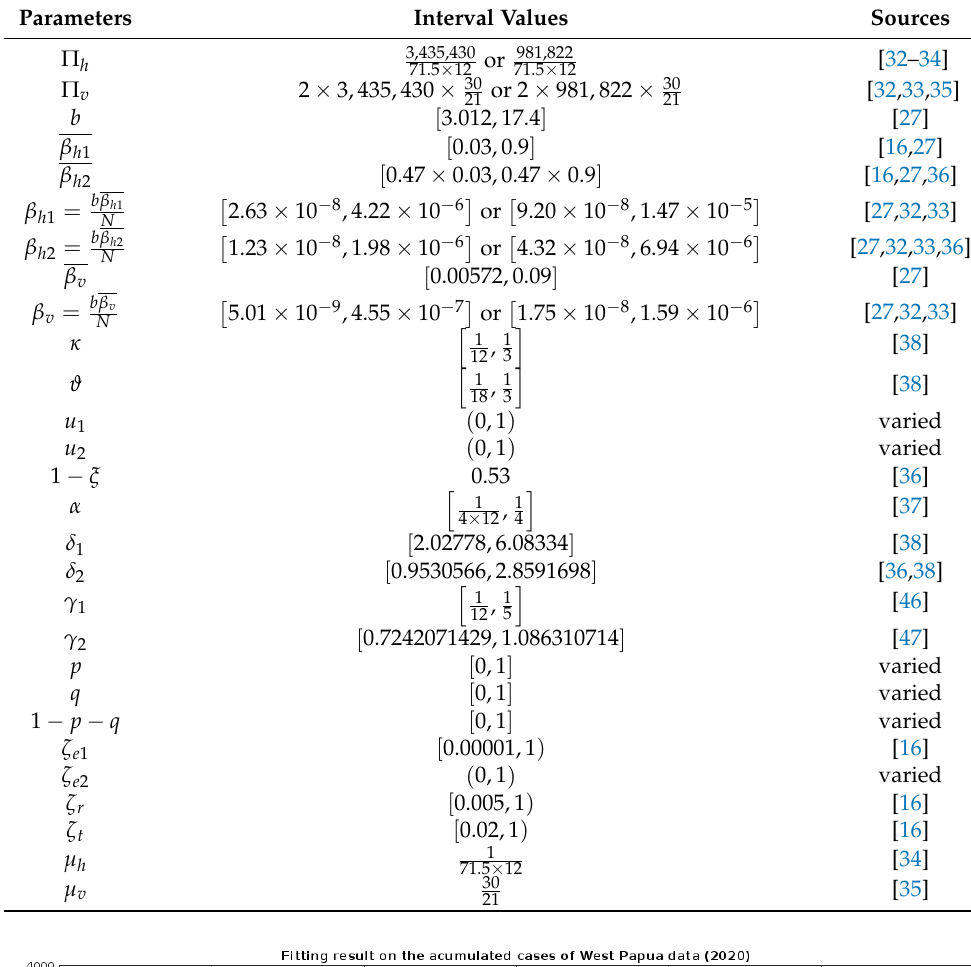
Table 2. Lower and upper bound of parameters that will be estimated.